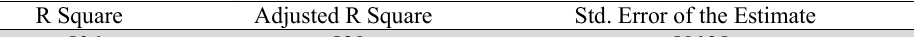
The examination of the explanatory level of the model (Model Summary b ) R Square Adjusted R